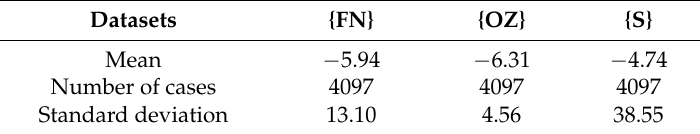
Table 2. Statistical features of the dataset.